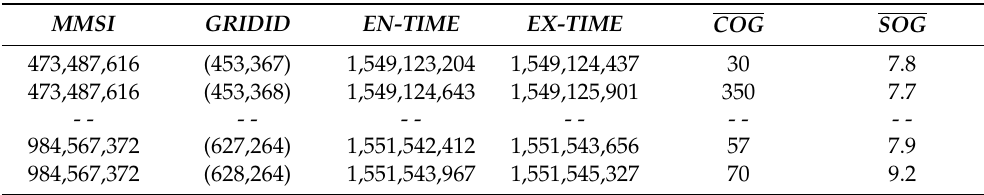
Table 1. Multi-motion attribute grid